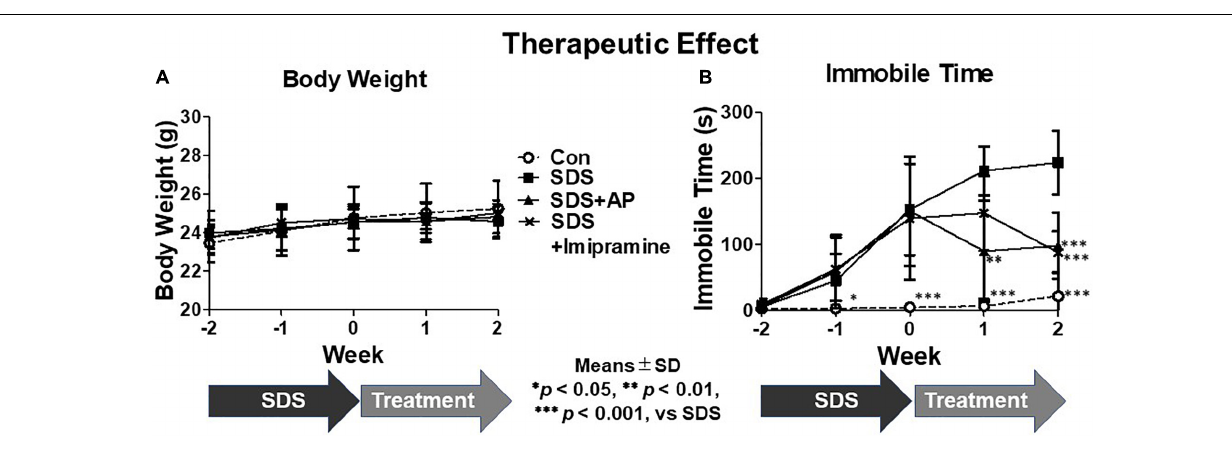
FIGURE 5 | Acupuncture showed therapeutic effect on depressive symptoms in mice induced by SDS. (A) Weight changes and (B) immobile time in the forced swimming test in mice during treatment of depression induced by SDS stress. Values are means ± SD ( n = 8). ∗ p < 0.05, ∗∗ p < 0.01, and ∗∗∗ p < 0.001 versus SDS group. AP, acupuncture; SD, standard deviation; SDS, social defeat